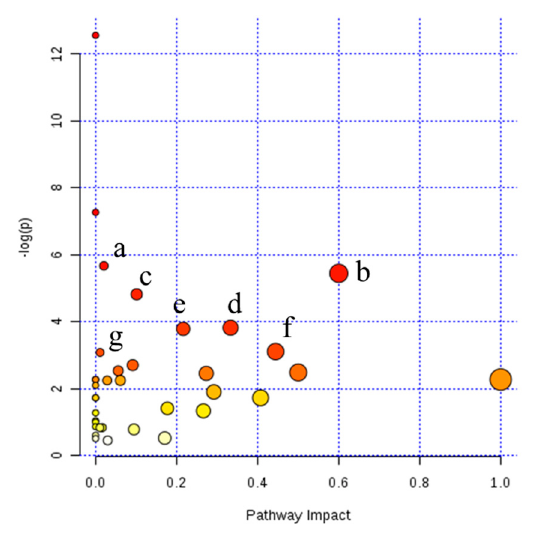
Figure 2. Pathway analysis of differential metabolites between β -casein variants A1/A1 and A2/A2 milk with MetaboAnalyst analysis. (a) Pantothenate and coenzyme A biosynthesis; (b) synthesis and degradation of ketone bodies; (c) butanoate metabolism; (d) valine, leucine and isoleucine biosynthesis; (e) glycerophospholipid metabolism; (f) glyoxylate and dicarboxylate metabolism; (g) valine, leucine and isoleucine degradation. Pathway impact on the horizontal axis calculated from pathway topology analysis; − log( p ) on the vertical axis calculated from the pathway enrichment analysis represented by the negative logarithm transformation of p -value.